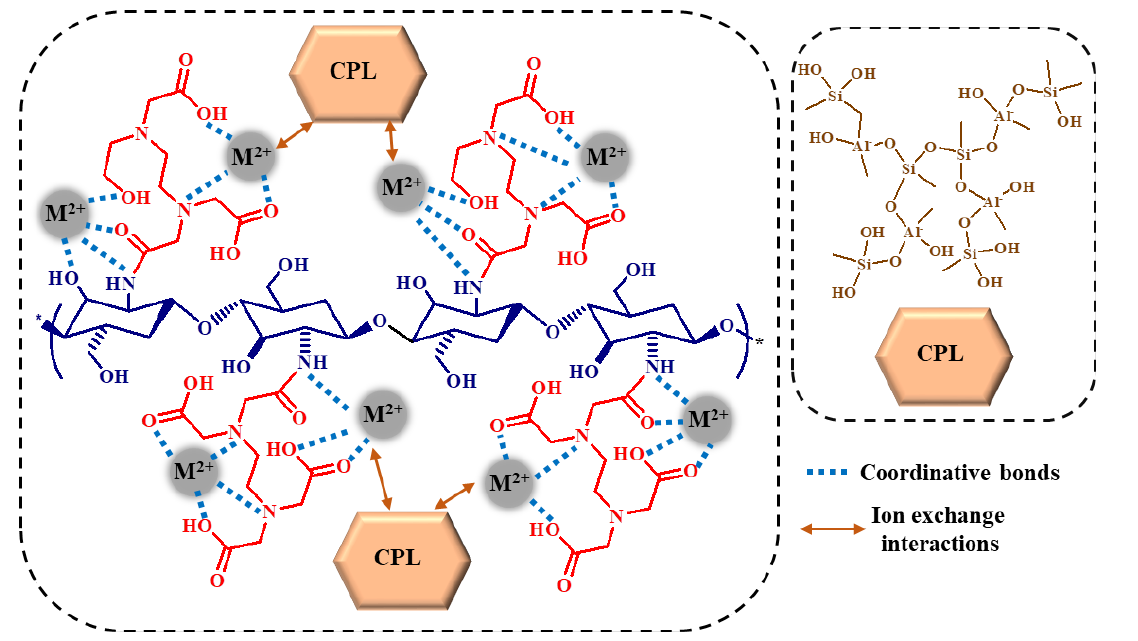
Figure 7. Possible mechanism for the sorption of HMIs onto the CS EDTA -CPL cryogel sorbents.